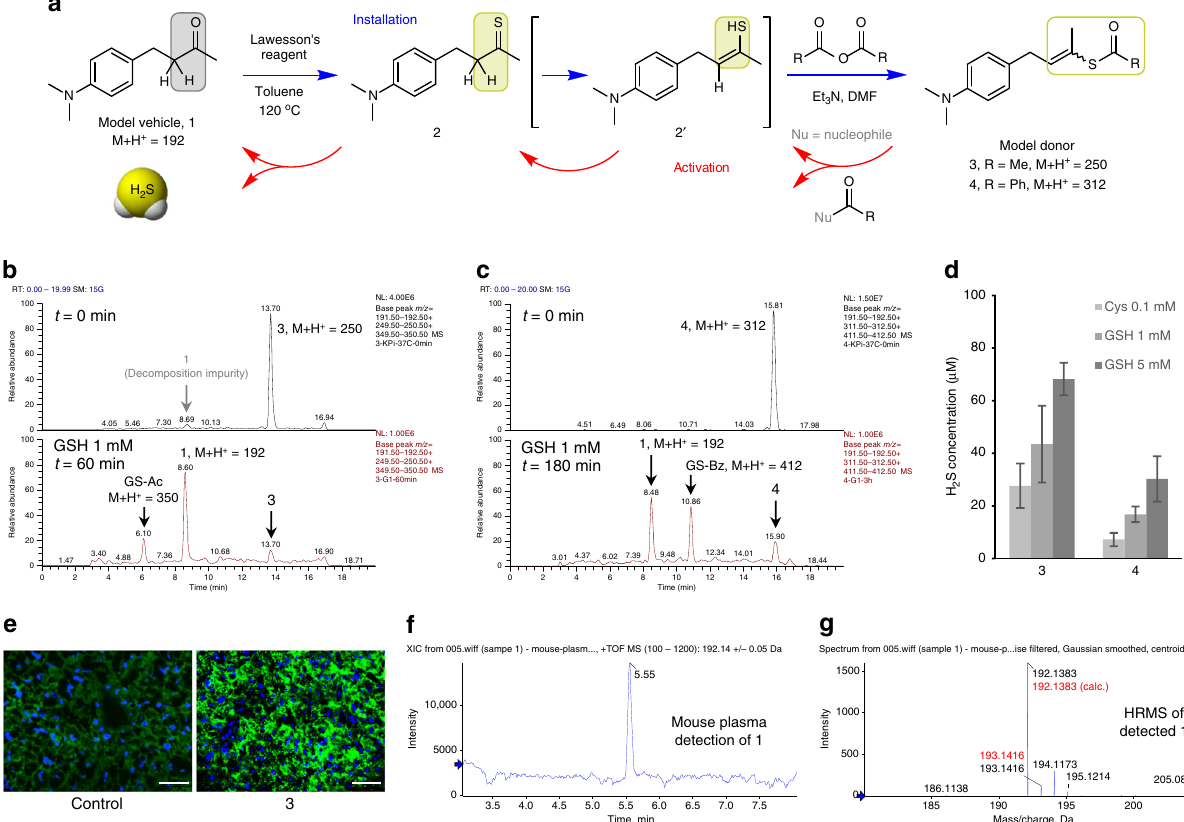
Fig. 5 Model studies of masked thioenols as fl exible H 2 S donors. a Facile preparation of H 2 S model donors from model vehicle 1 (blue arrows) and proposed activation through nucleophilic deacylation (red arrows). b In vitro activation of model donor 3 (100 μ M) by GSH (1 mM, 60 min) shows recovery of model vehicle 1 and acetylated GSH (GS-Ac) in LC-MS/MS studies. c In vitro activation of model donor 4 (100 μ M) by GSH (1 mM, 180 min) shows recovery of model vehicle 1 and benzoylated GSH (GS-Bz) in LC-MS/MS studies. d The H 2 S released from in vitro activation of model donors (100 μ M) by L -cysteine (Cys, 0.1 mM) or GSH (1 or 5 mM) after 1 h was detected by methylene blue method (data is displayed as means± S.D., n = 3). e In vivo study of (model vehicle 1 ) from 3 in mouse plasma from in vivo studies ( n = 4). g HRMS data of detected model vehicle 1 from mouse